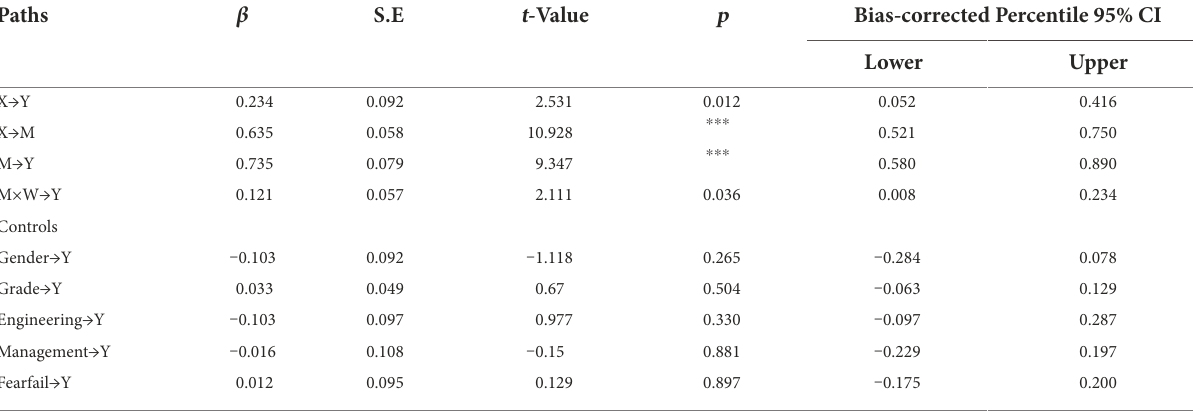
TABLE 5 | Direct, indirect and conditional